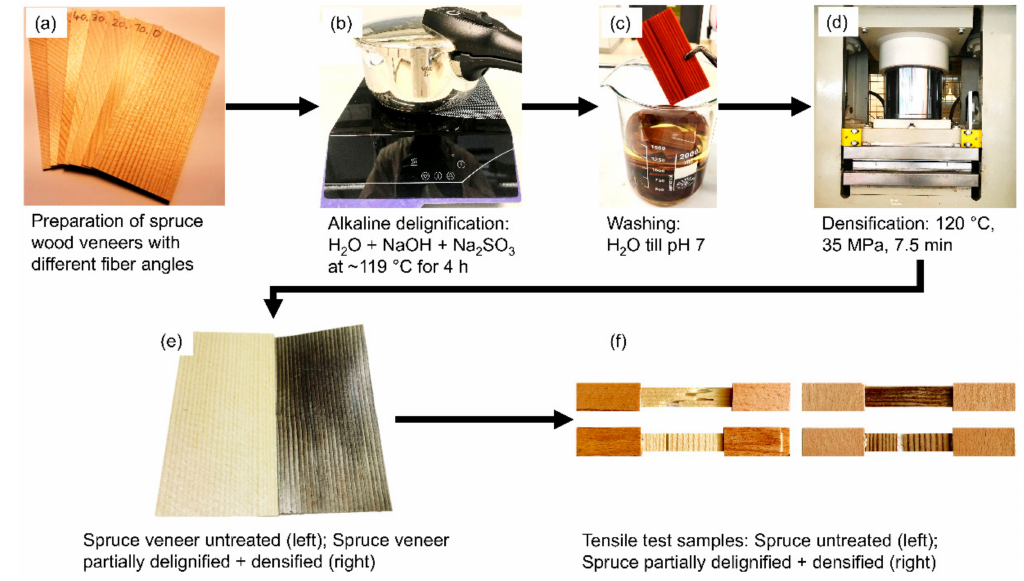
Figure 1. Key treatment steps in the preparation of partially delignified and densified spruce wood